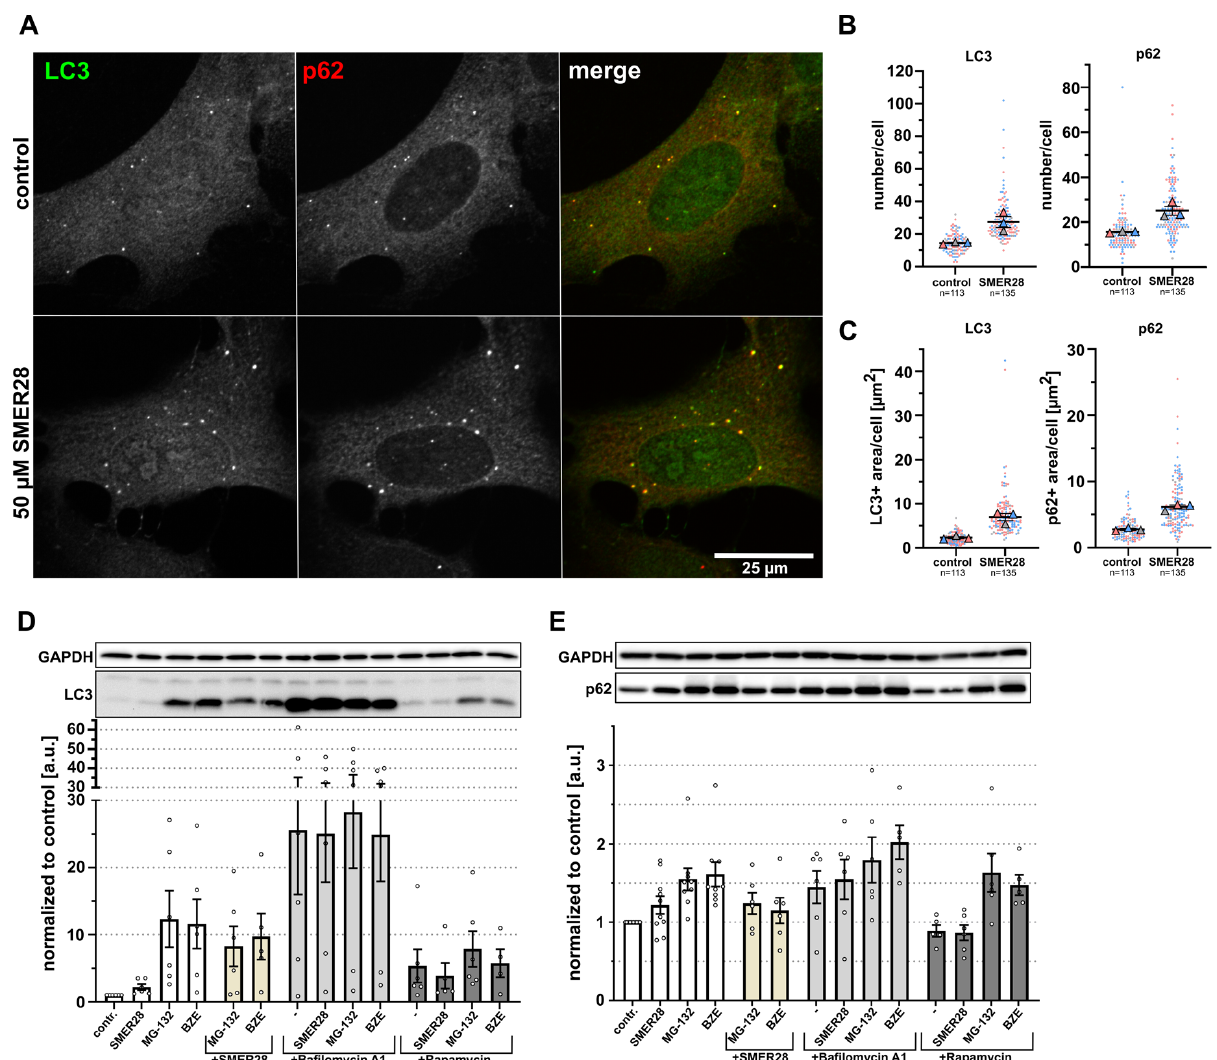
Figure 1. SMER28 stimulates autophagy in U-2 OS cells. ( A ) U-2 OS cells were left untreated (upper panel) or treated with 50 µ M SMER28 for 16 h (lower panel). Cells were stained with p62/SQSTM1 and LC3 antibodies to assess markers for autophagosomes and visualized by confocal spinning disk microscopy. Merged images show LC3 in green and p62 in red. ( B , C ) Quantification of average numbers ( B ) and total areas ( C ) of LC3-positive and p62-positive puncta per cell. Data are shown as scatter plots with means ± s.e.m.; n = total number of cells analyzed; each biological replicate is colour-coded, large symbols depict means of respective experiments, according to “SuperPlots” [24]. ( D , E ) U-2 OS cells were treated with 50 µ M SMER28, 1 µ M MG-132, 15 nM bortezomib (BZE) and in the presence or absence of 250 nM bafilomycin A1 or 300 nM rapamycin for 16 h, as indicated and lysed in lysis-buffer. Protein levels of LC3 ( D ) and p62 ( E ) were assessed by WB; GAPDH was used as loading control. Graphs show quantifications of relative LC3-II and p62 levels after treatments as indicated. Data are means ± s.e.m; n ≥